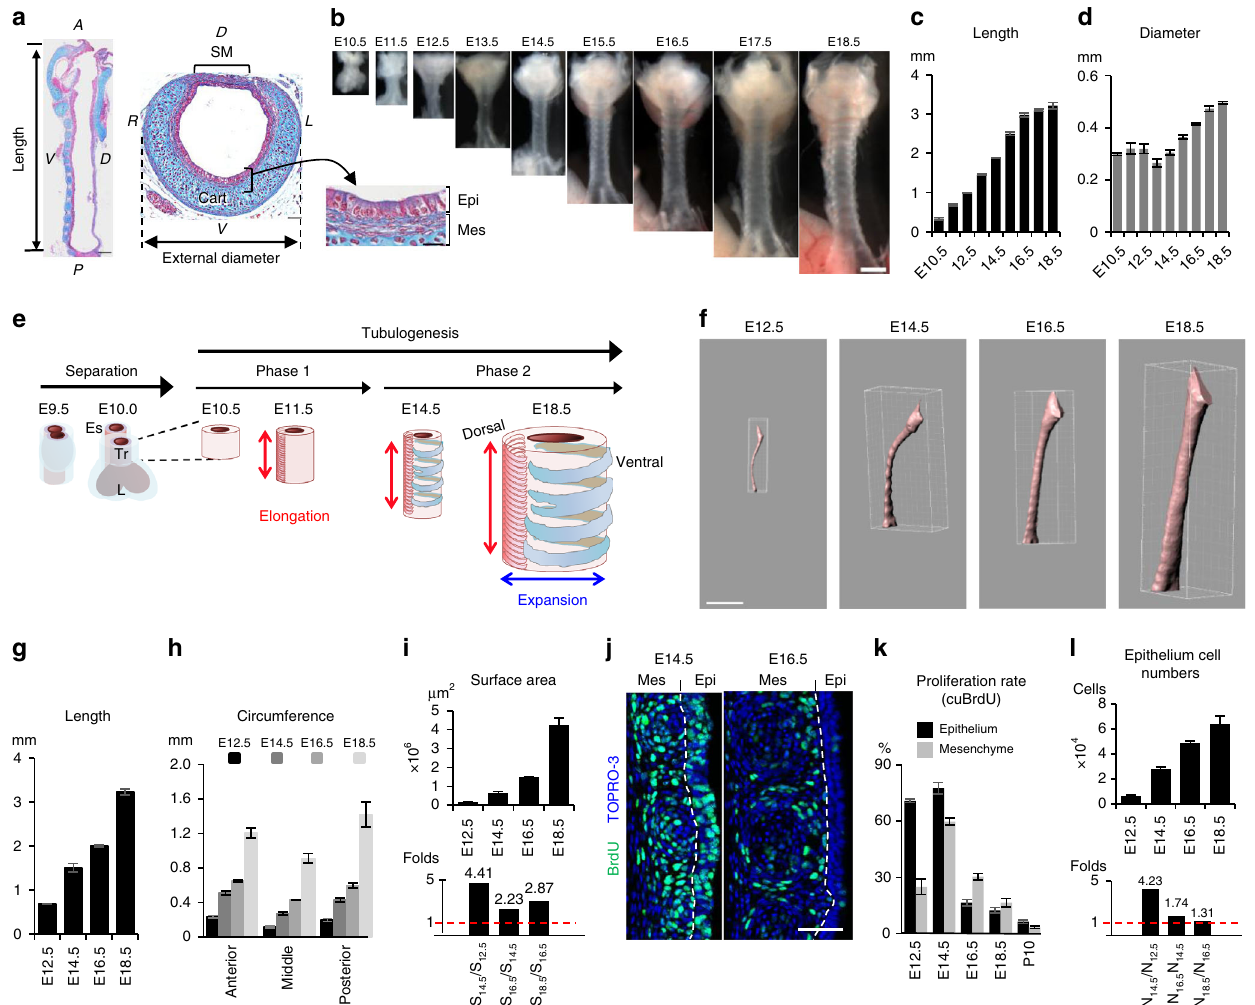
Fig. 1 Tracheal tubulogenesis process. ( a ) Azan staining of trachea at E18.5. Length was de fi ned as the distance from the larynx to the main branch. ( b ) Gross morphology of developing trachea. Tube length ( c ). External diameter ( d ). Data represent means ± SEM ( n ≥ 3). ( e ) Schematic model of trachea tubulogenesis. Red and blue arrows indicate length and diameter expansion. f 3D-luminal structures of whole tracheas reconstructed from micro-CT images using IMARIS. See also Supplementary Movie 1. Quanti fi cation of the length ( g ), circumference ( h ), and luminal-surface area ( i ) ( n ≥ 4). Change in luminal surface area ( i , upper panel) and the fold change ( i , lower panel) over time are shown. Data represent means ± SEM ( n ≥ 3). j Sections of BrdU- incorporated developing trachea were stained for BrdU (green) and TOPRO-3 (blue). Dotted lines indicate epithelium – mesenchyme boundary. k Rate of proliferating cells determined by cumulative BrdU-incorporation assay. Data represent means ± SEM ( n ≥ 4). l The numbers of epithelial cells (upper panel) and fold changes (lower panel) in whole trachea over time. Data represent means ± SEM ( n ≥ 3). A anterior; D dorsal; L jeft; P posterior; R right; V ventral; cart cartilage; SM smooth muscle; Epi epithelium; Mes mesenchyme; Tr trachea; Es esophagus. Scale bar = 500 μ m ( b , f ), 200 μ m ( a ; sagittal view), 50 μ m ( a ; transversal view, j